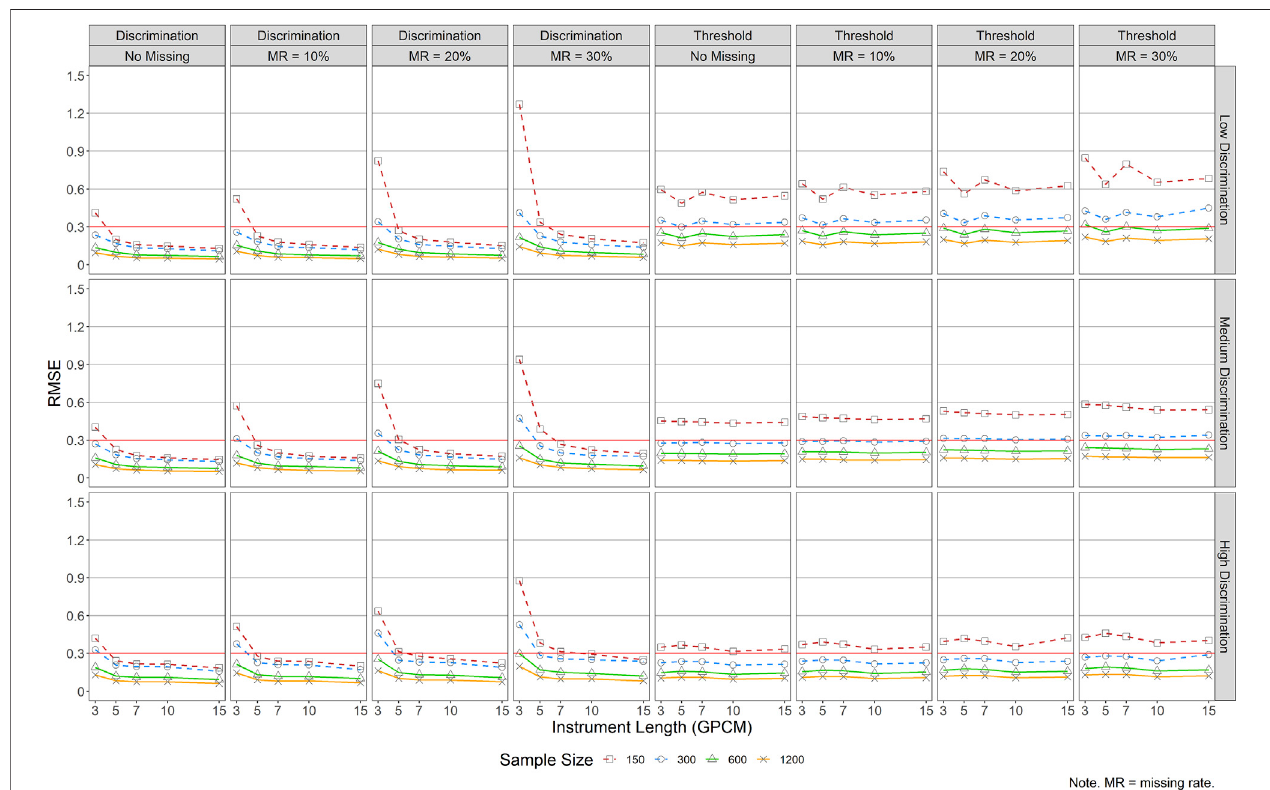
FIGURE 5 | RMSE of Item Parameter Estimations for GPCM. Note. MR (cid:1) missing